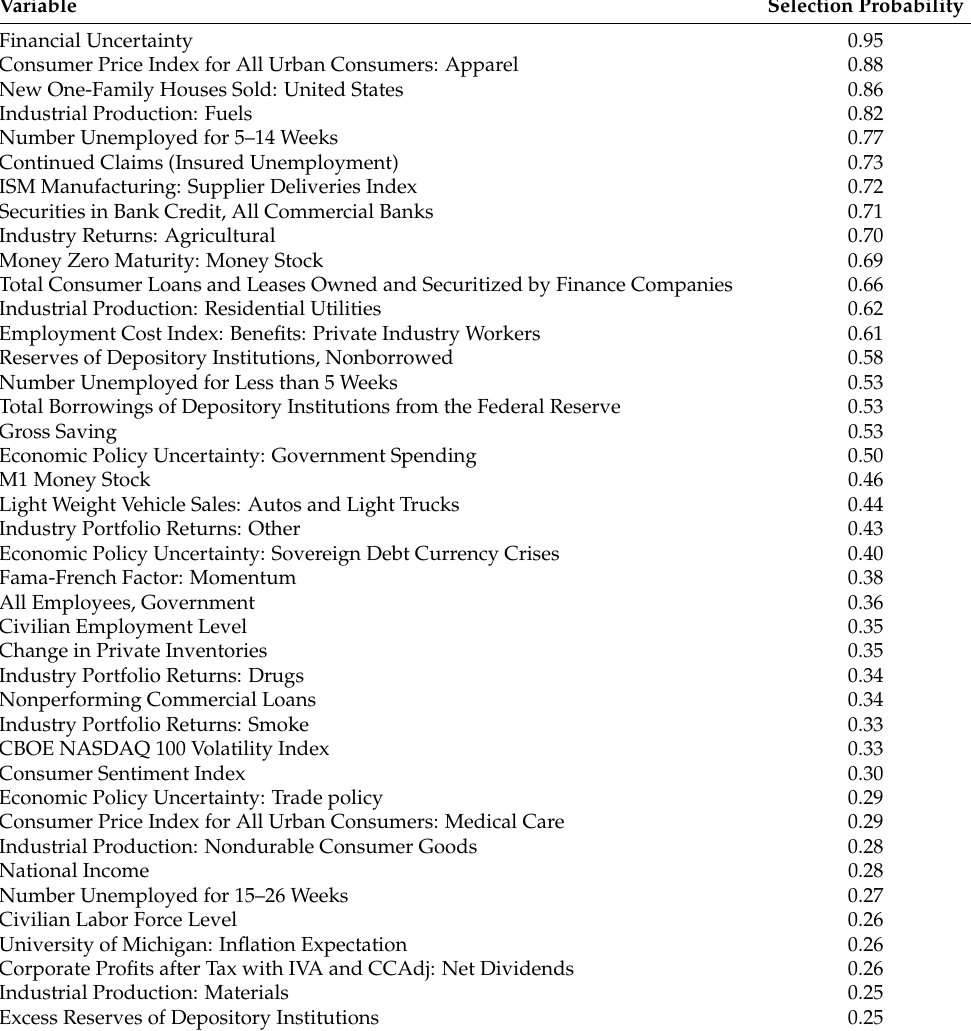
Table 12. List of predictor probabilities from lasso with stability